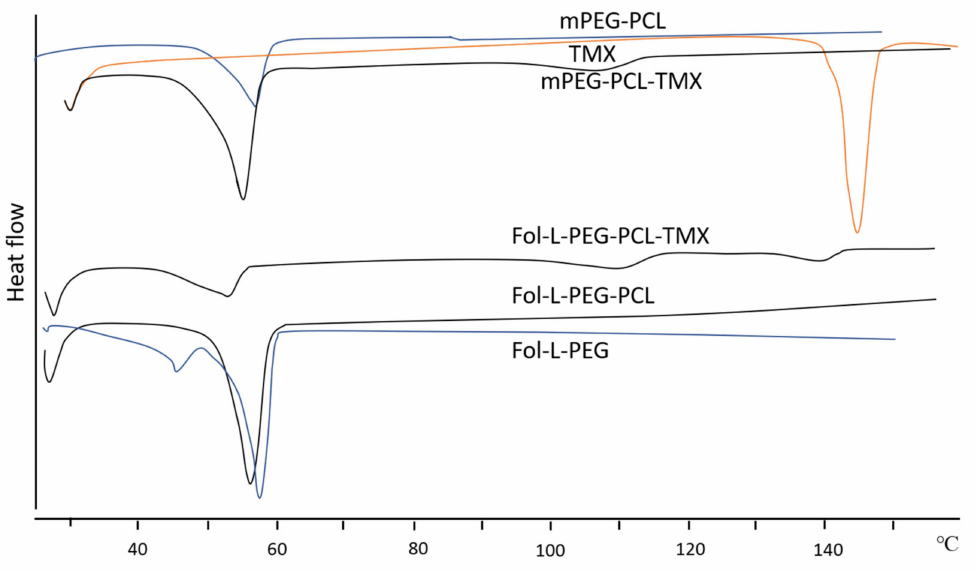
Figure 6. DSC curves of copolymers and drug-loaded copolymers. Reprinted/adapted with permis- sion from Elsevier